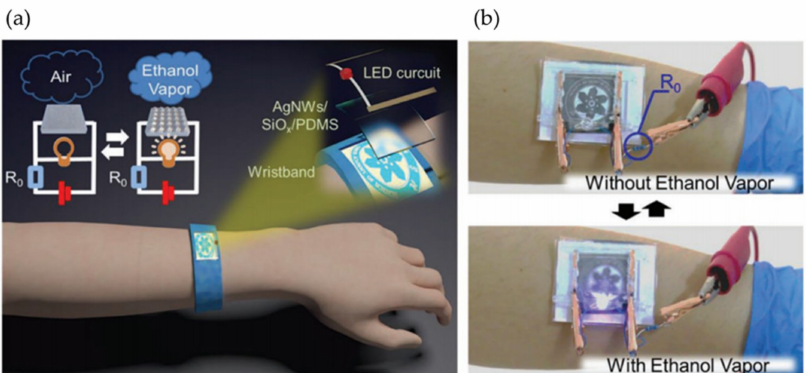
Figure 22. ( a ) Schematic illustration of the smart wearable and flexible electronic device based on the Ag nanowire/PDMS multilayered film and ( b ) a proof-of-concept wearable device that responds to ethanol vapor directly dynamic visual and electrical feedback. Reproduced with permission from reference [84]. Copyright 2019, John Wiley & Sons,